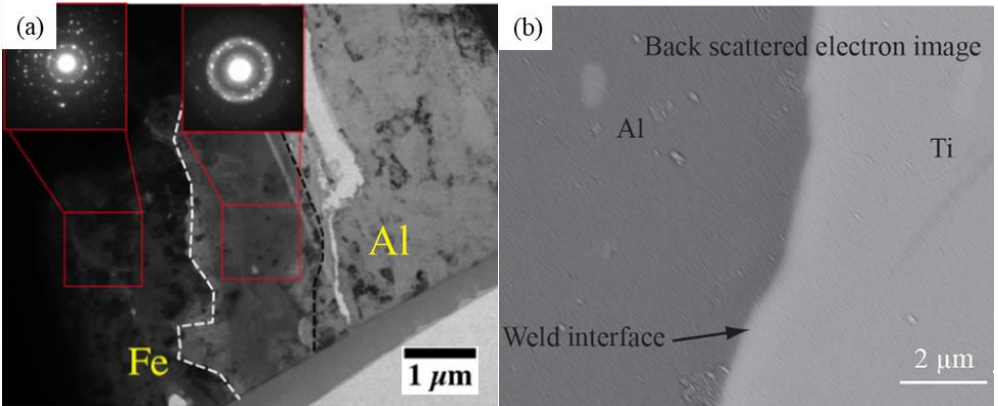
Figure 12. Two welding interfaces of impact welding ( a ) Transition zone interface (reproduced from [49], with permission of Elsevier 2019); ( b ) Interface without transition zone (reproduced from [24], with permission of Laser Institute of America 2016).